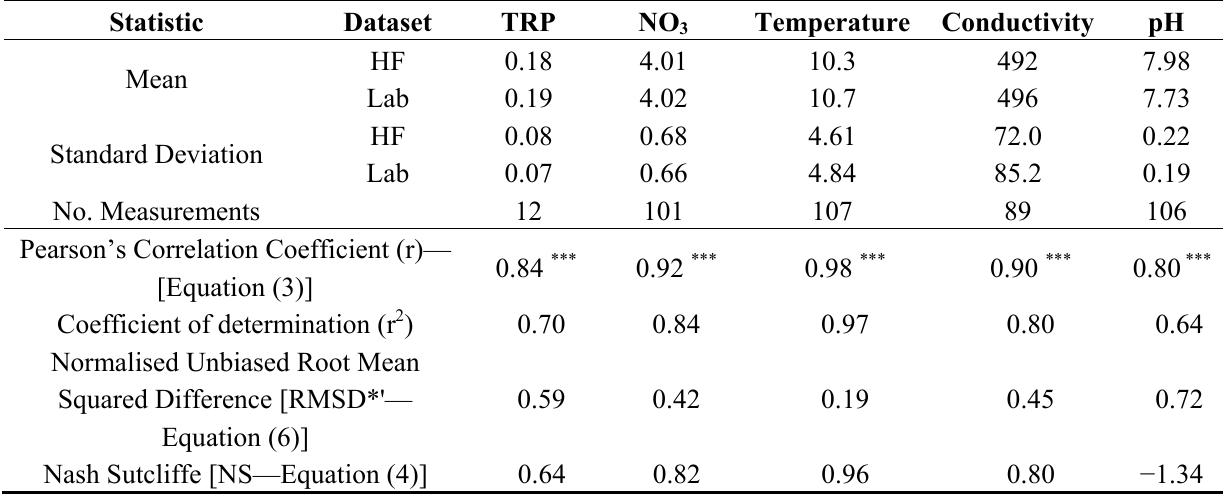
Table 5. Goodness of fit statistics between the traditional laboratory hydrochemical measurements (Lab) and the measurements made in situ by the high-frequency equipment